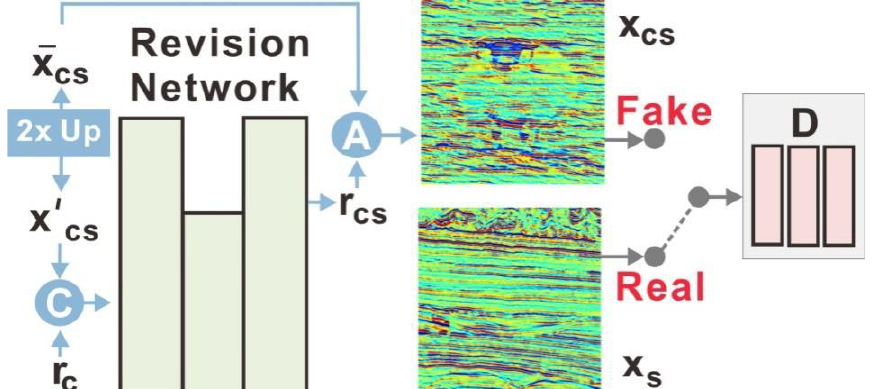
Figure 5. Schematic diagram of network revision [29]. C and A represent concatenation and aggregation operations separately. The residual detail image r c is connected with the result image x cs′ of the drafting network stage after double up-sampling. After revising the network, the residual detail image r cs of the image is generated to modify the rough stylized image x cs . Then r cs is combined with the rough stylized image x cs to generate the final stylized image which is output through the discriminator with the style image x s